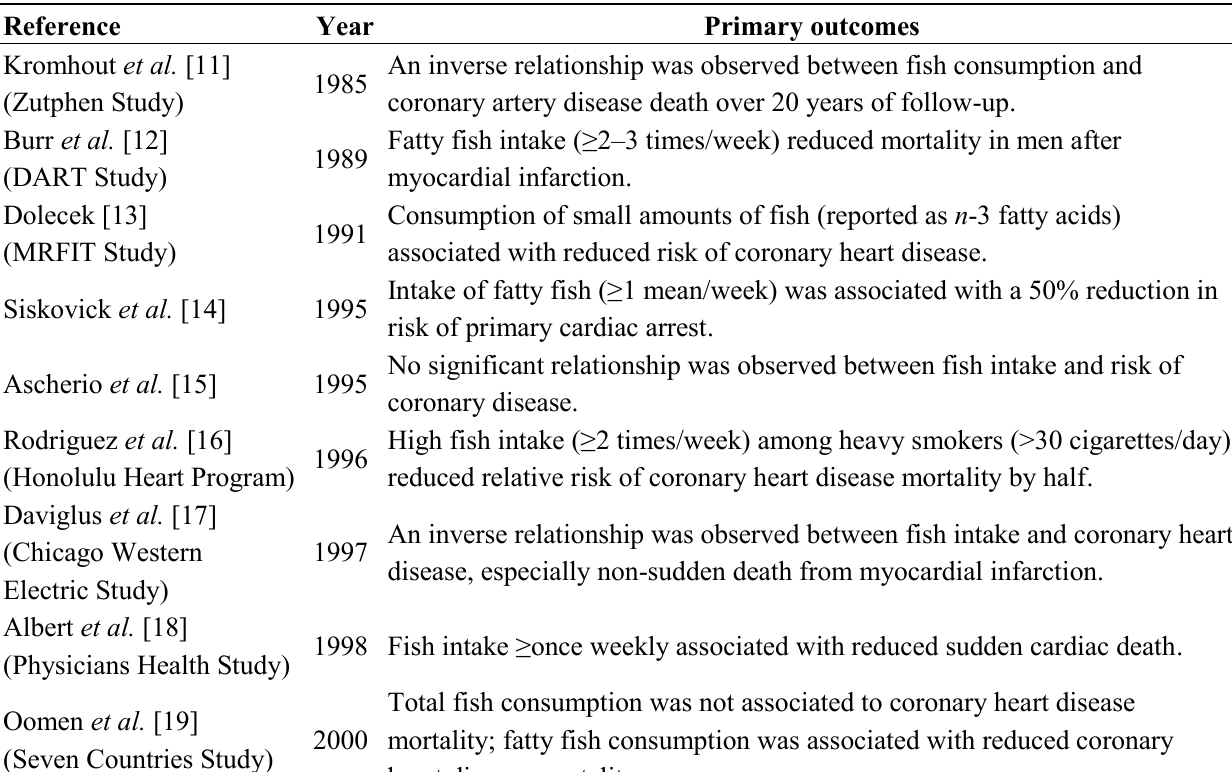
Table 1. Reported fish consumption and cardiovascular